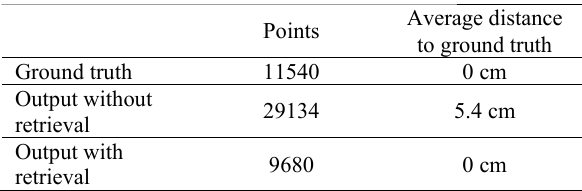
Table 1 . Comparison between ground truth, output of the point based mathematical opening and the proposed method in terms of number of points and average distances to the nearest point of the ground truth data.